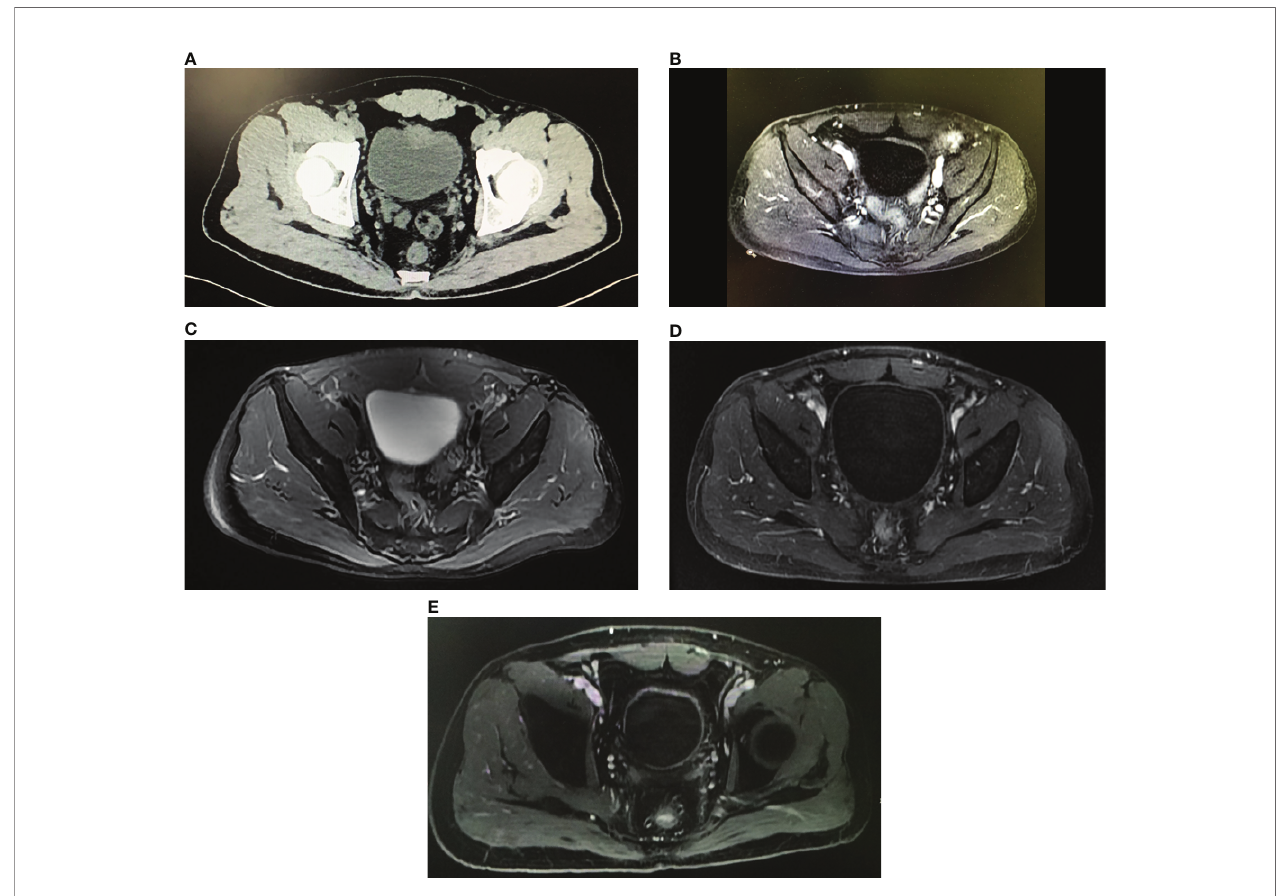
FIGURE 1 | Imaging of the patient over the course of therapy. (A) The axial pelvic CT image before treatment demonstrated a mass was about 3.0 cm arising from the anterior wall of the bladder and the perivesical fat was invaded. (B) After two cycles of neoadjuvant therapy, the axial image from dynamic contrast-enhanced pelvic MRI indicated the thickness of enhanced anterior wall of the bladder decreased. (C) After four cycles of neoadjuvant therapy, the axial T2W image from pelvic MRI showed the light thickening of the anterior wall was persisting, but no node or tumor was found. (D) After concurrent chemoradiotherapy plus pembrolizumab, the axial contrast-enhanced MRI on arterial phase showed the bladder was normal with no sign of tumor recurrence. (E) The axial contrast-enhanced MRI on arterial phase still showed no tumor in the bladder at the last follow-up on February 20,